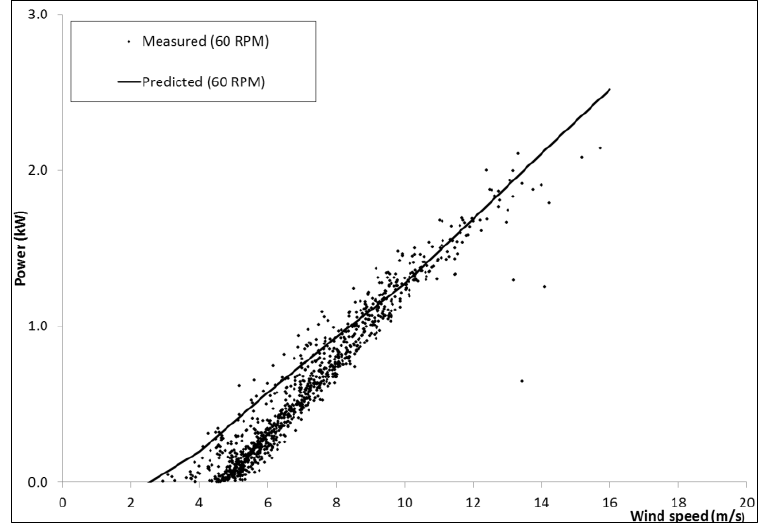
Figure 12. NOVA prototype rotor power vs. wind speed at 60